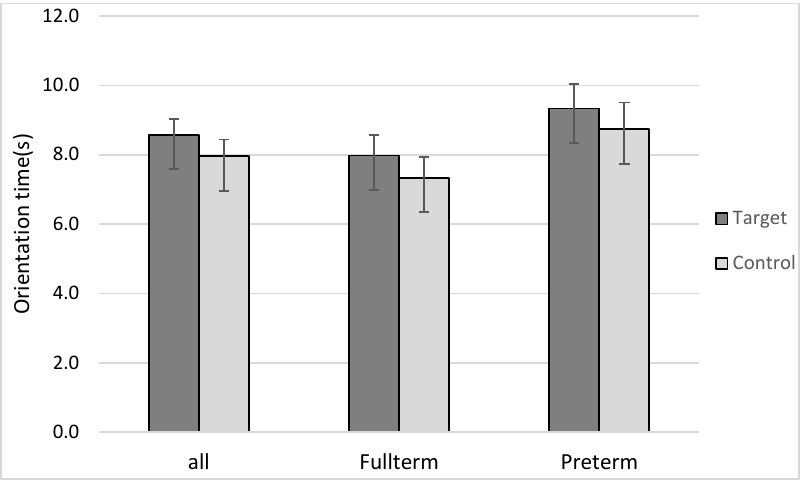
Figure 1. Mean orientation times (OTs) for all bilingual infants ( left ), full-term infants ( middle ) and preterm ( right ) for target and control words.